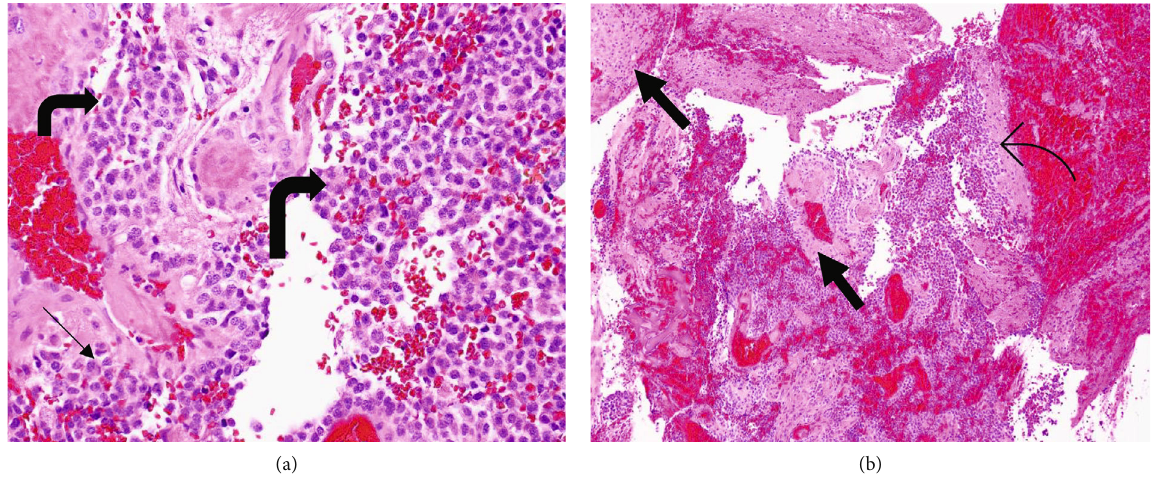
Figure 2: Histology images of the biopsy specimen of the Brain. (a) Hematoxylin and eosin photomicrograph high power view (400x) of high-grade small ovoid poorly di ff erentiated neoplastic cells with a high N:C ratio (curved arrows) in the brain parenchyma (straight arrow). (b) Hematoxylin and eosin photomicrograph low power view (100x) of high-grade small ovoid poorly di ff erentiated neoplastic cells with a high N:C ratio (curved arrow) with scant areas of the brain parenchyma (straight